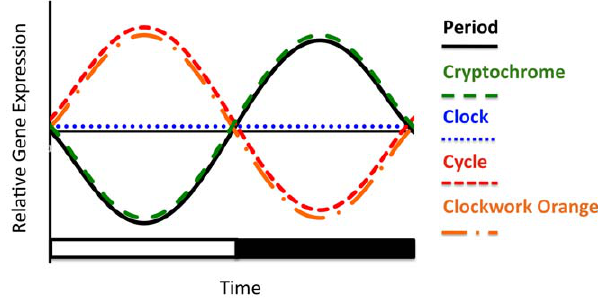
Figure 6. Summary representation of oscillation in mRNA for five core clock genes in fire ant brains under LD illumination. Shown are four genes ( SiPer, SiCry, SiCwo, and SiCyc) that show significant oscillations and have significant correlations to the cosine model with R 2 adj $ 0.5, and one gene, SiClk , which does not oscillate. Lines represent schematic cartoons of the actual oscillations. SiPer and SiCry cycle in the same phase and peak during the night and SiCwo and SiCyc cycle antiphase to SiPer and peak during the day. Not shown on the figure are the two transcription factors, SiVri and SiPdp1 ; SiTim was excluded because the expression of this gene was not consistent across nests.